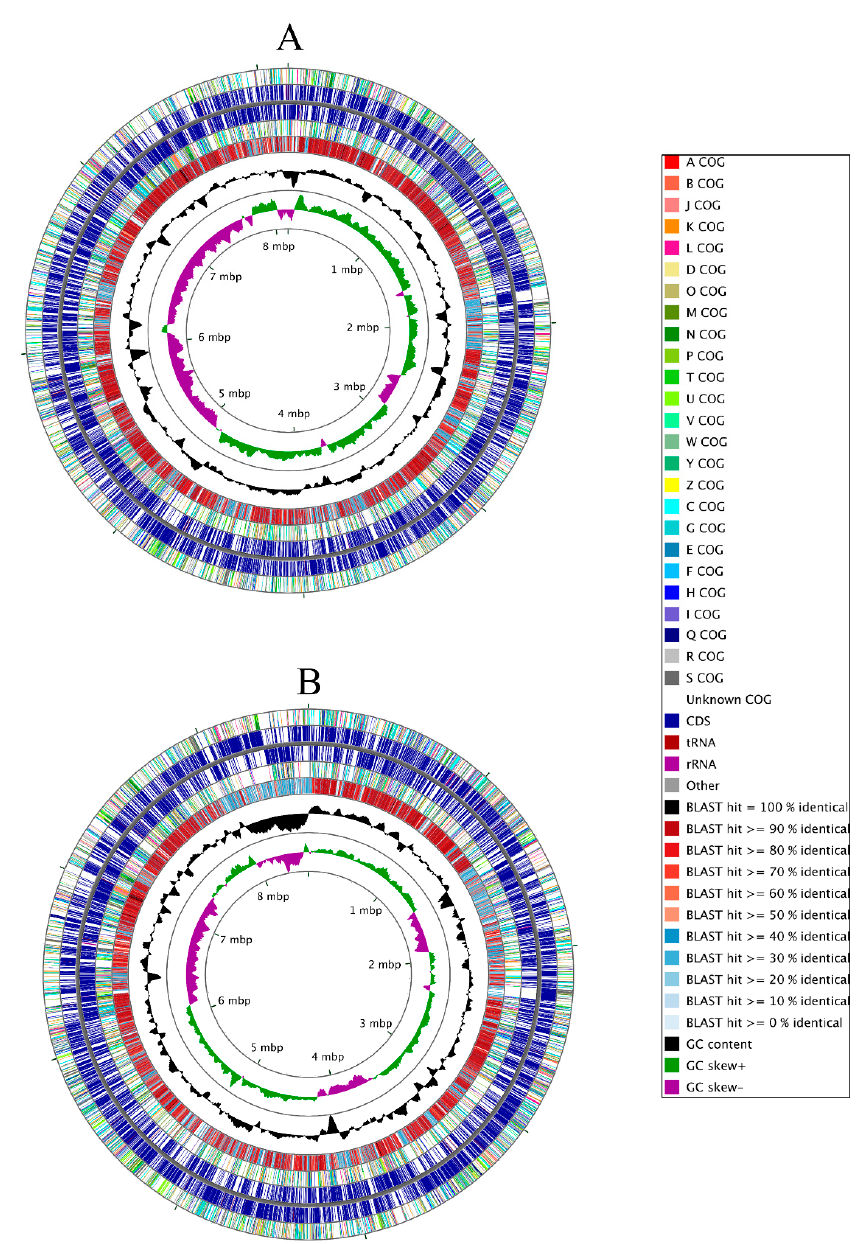
Figure 2. Shown are circular genomic maps of Burkholderia sp. strain SRS-25 ( A ) and SRS-46 ( B ). The first (outermost) and fourth rings depict COG categories of protein coding genes on the forward and reverse strands; the second and third rings show the locations of protein coding, tRNA, and rRNA genes on the forward and reverse strands; the fifth ring displays regions of similarity detected using BLAST (E-value = 0.0001) between strain SRS-25 or SRS-46 coding sequence translations and those from the genome of Burkholderia multivorans ATCC 17616 (accessions CP000868, CP000869, CP000870, CP000871). Regions of similarity are colored based on the percent identity between the aligned proteins. The black plot depicts GC content with the peaks extending towards the outside of the circle representing GC content above the genome average, whereas those extending towards the center